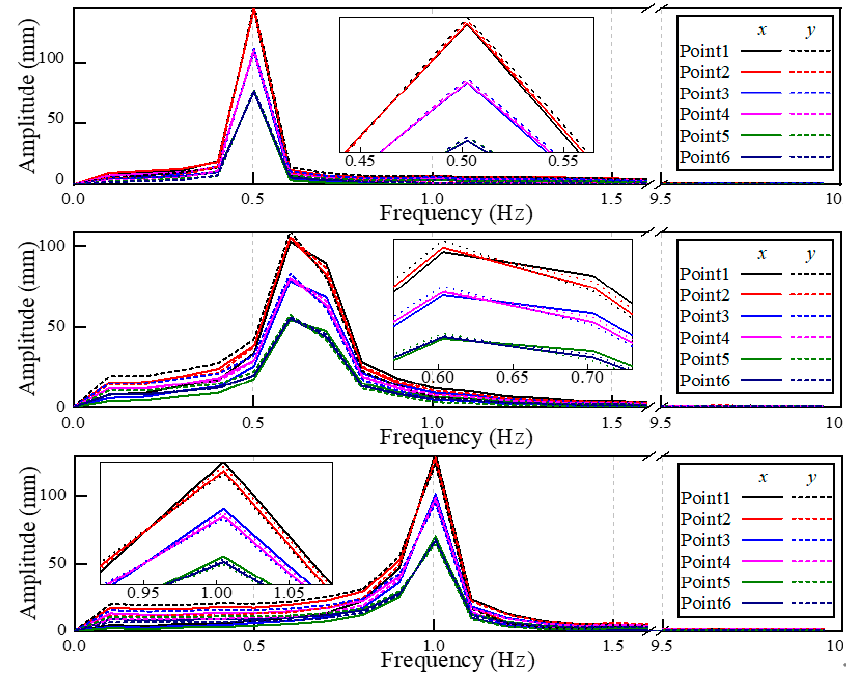
Figure 12. The frequency spectrum of dynamic displacement.